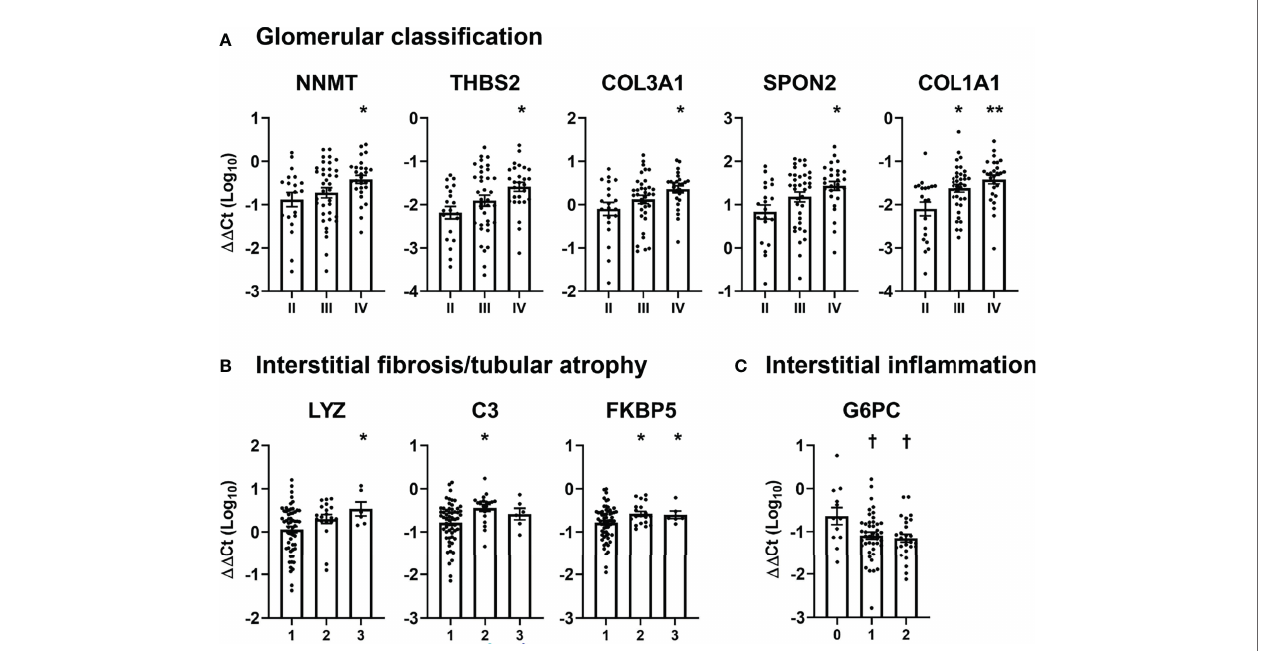
FIGURE 3 | Association between pathologic classi fi cations and urinary mRNA levels in patients with diabetic kidney disease. (A – C) The levels of signi fi cantly altered urinary mRNAs according to (A) glomerular classi fi cation, (B) interstitial fi brosis and tubular atrophy, and (C) interstitial in fl ammation scores in patients with diabetic kidney disease are shown. Levels of each mRNA are expressed as log-transformed delta-delta cycle threshold ( DD Ct) after adjusting for 18S rRNA and controls. * p < 0.05, ** p < 0.005, up-regulated vs . glomerular class II or IFTA score of 1; † p < 0.05, down-regulated vs . interstitial in fl ammation score of 0.